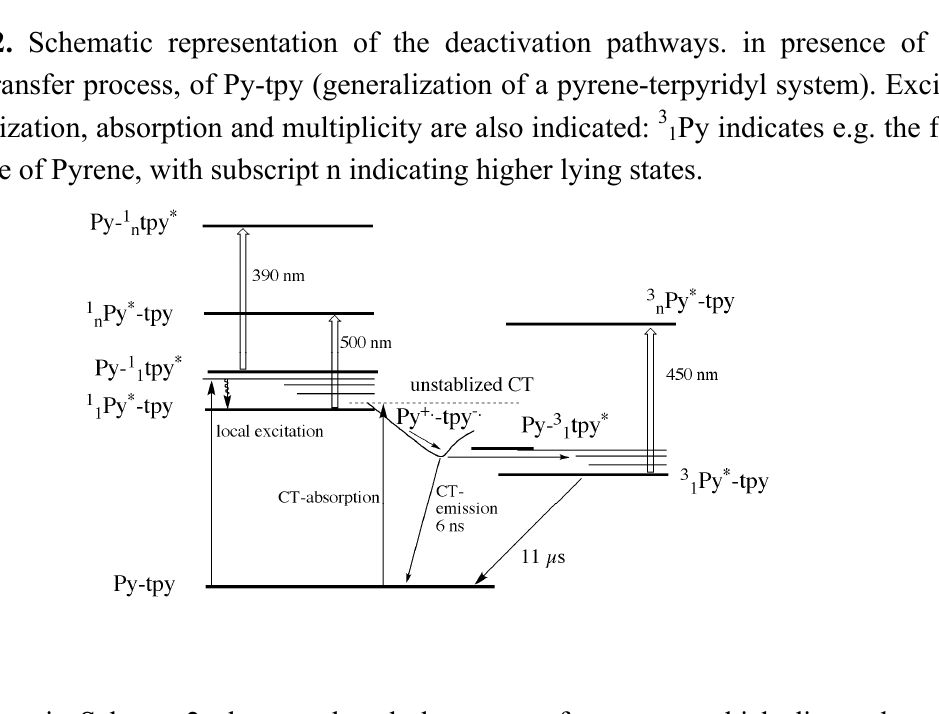
Py indicates e.g. the first 1